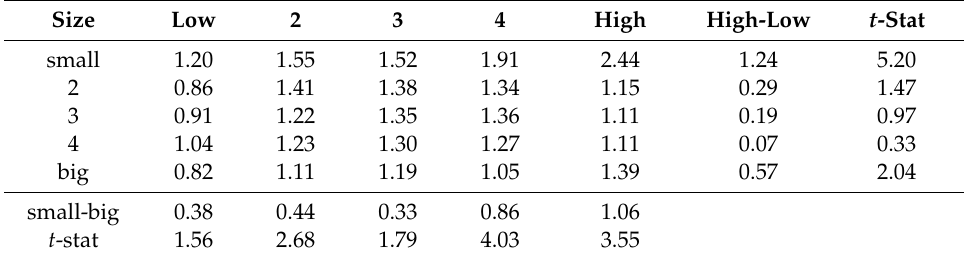
Table 11. Average returns from double-sorted quantile portfolios (sorted by size and Geske’s short-term minus forward default probability). From the data for July 1963 to December 2013, at the end of each month, stocks are independently sorted into 5 × 5 portfolios based on size and Geske’s short-term minus forward default probability. The table shows average returns for each of 25 portfolios. Small-big is the return di ff erential between the small and big firm portfolios within each default quantile. High-low is the return di ff erential between the high and low default probability firms within each size quantile. t -statistics are calculated using Newey-West standard